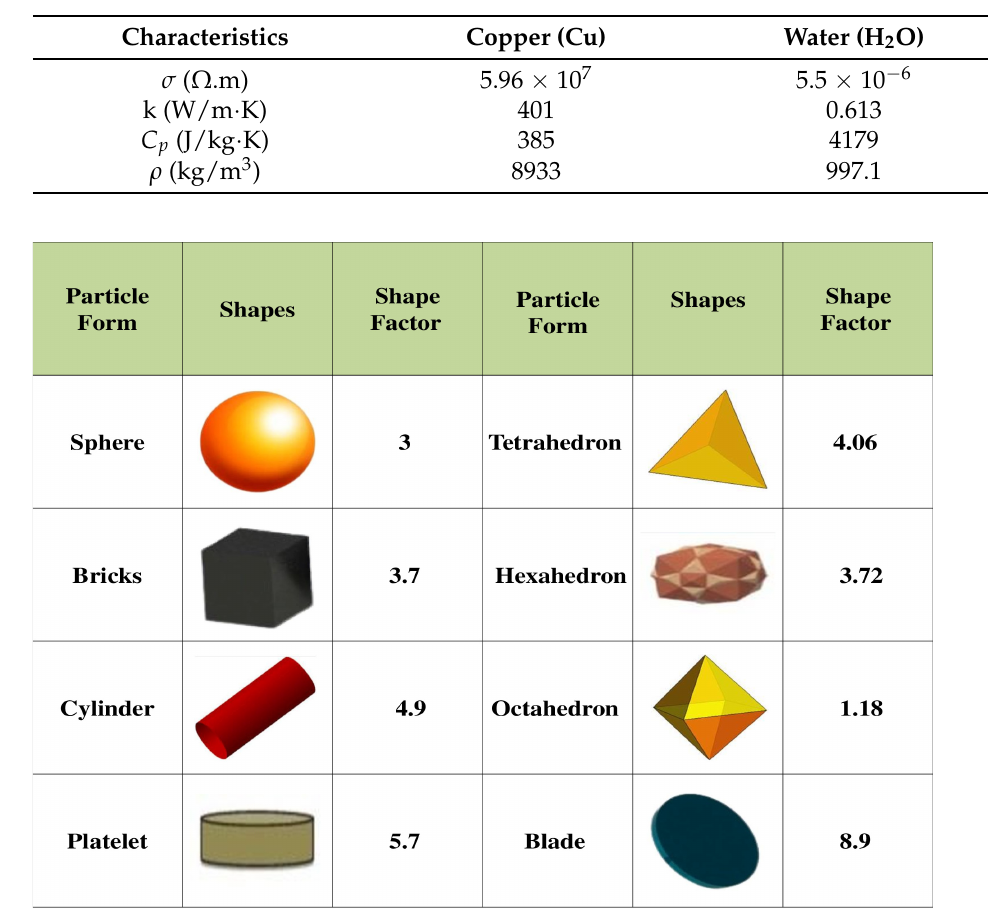
Table 1. Base liquid and nanoparticles’ thermo-physical properties at 25 ◦ [51].